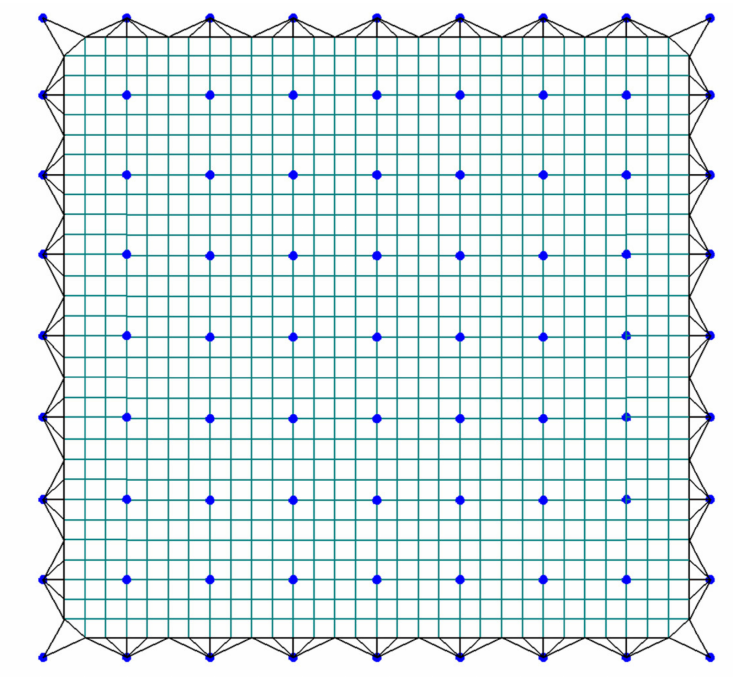
Figure 4. The configuration of an antenna mesh reflector.